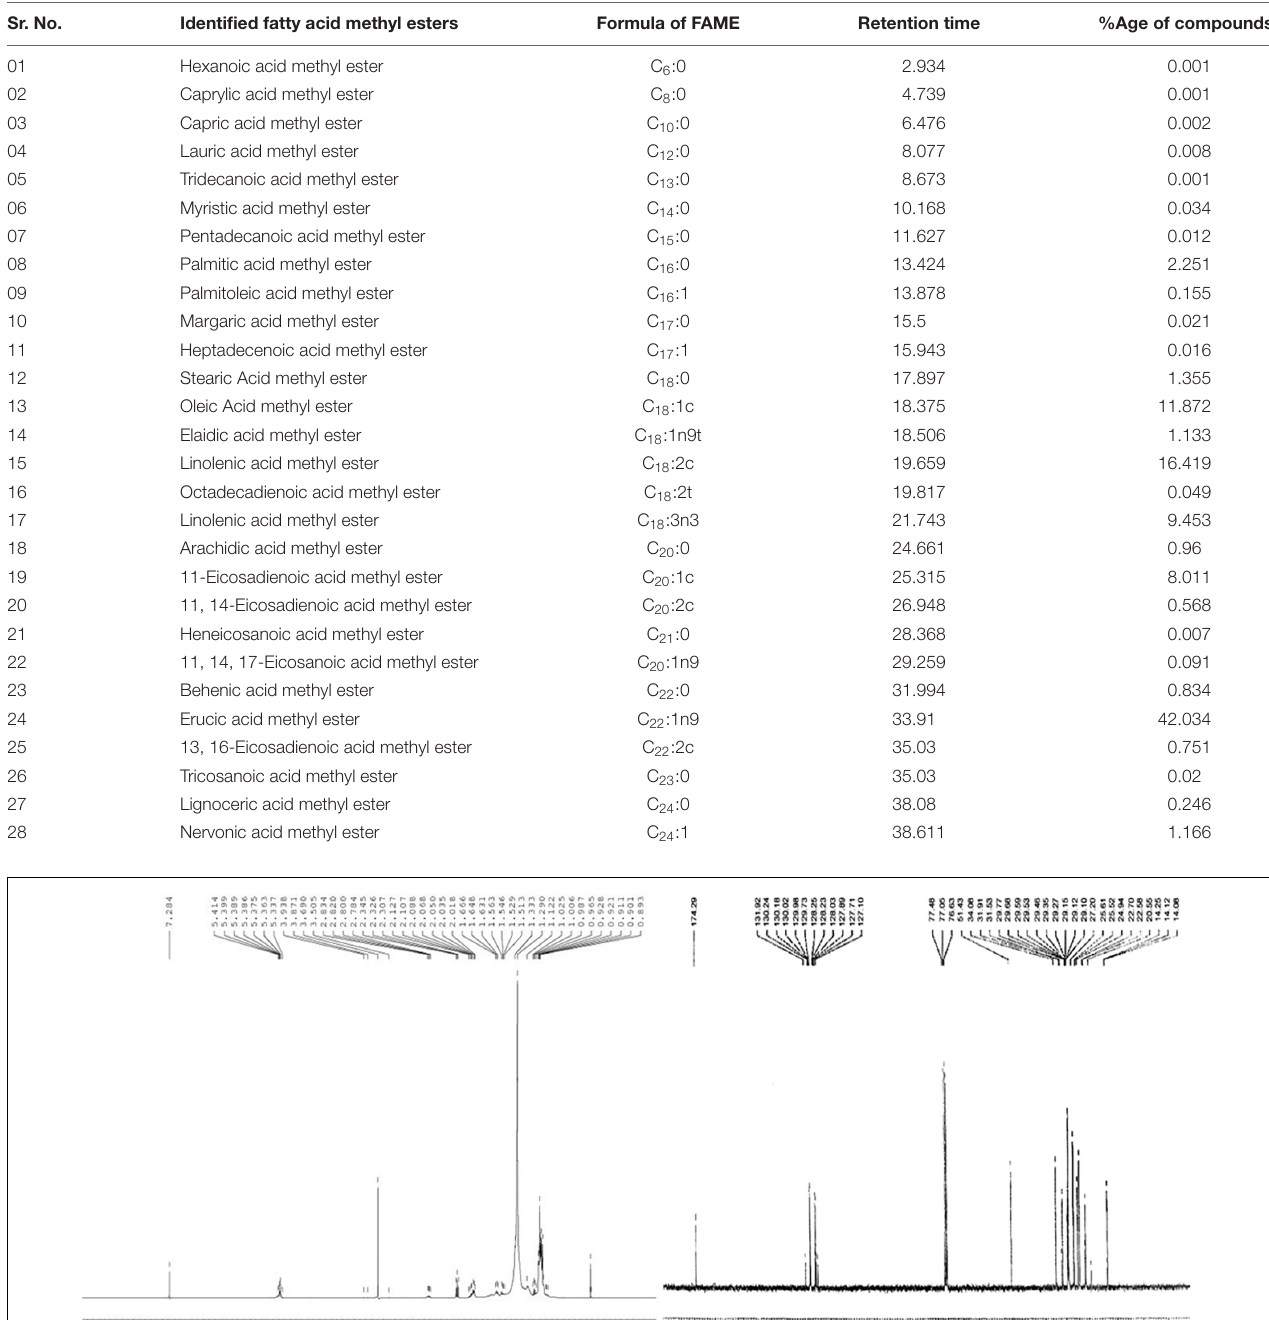
TABLE 3 | Reported Fatty Acid Methyl Esters in Energy Crop Cocklebur Biofuel, With Retention Time and %tage using GC/MS. Sr. No.